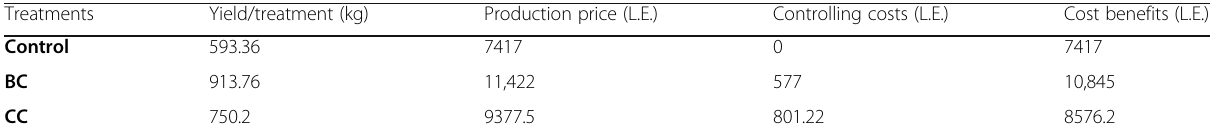
Table 6 Total yield production, controlling costs, and cost benefits of sweet pepper after using biological and chemical control, and the untreated control in the experimental tunnels Treatments Yield/treatment